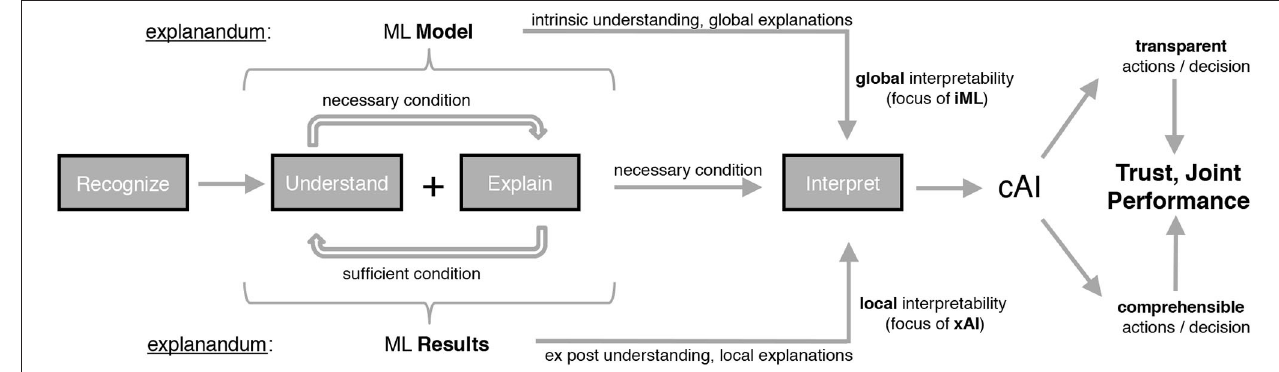
FIGURE 3 | Derivation of cAI from iML and xAI considering the underlying cognitive